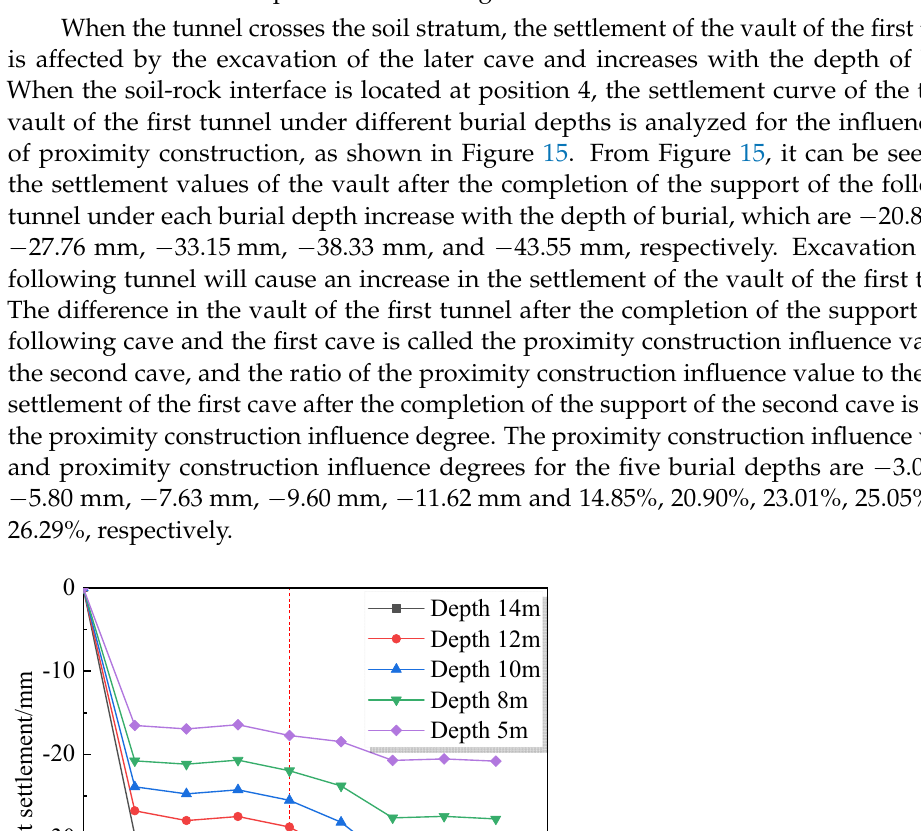
Figure 14. Plastic zone of the middle rock column at four soil-rock interface positions (depth: 14 m).